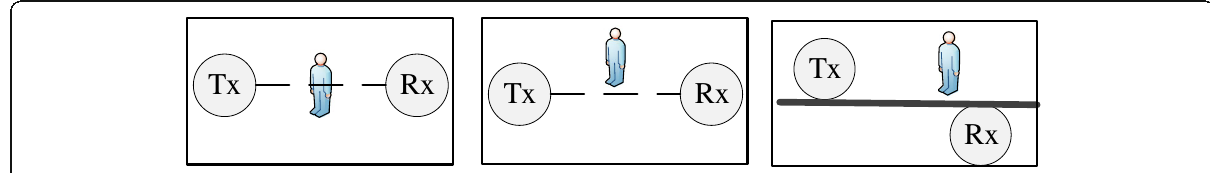
Fig. 2 Experimental scenario layouts. a Line-of-sight, b non-line-of-sight, and c through one